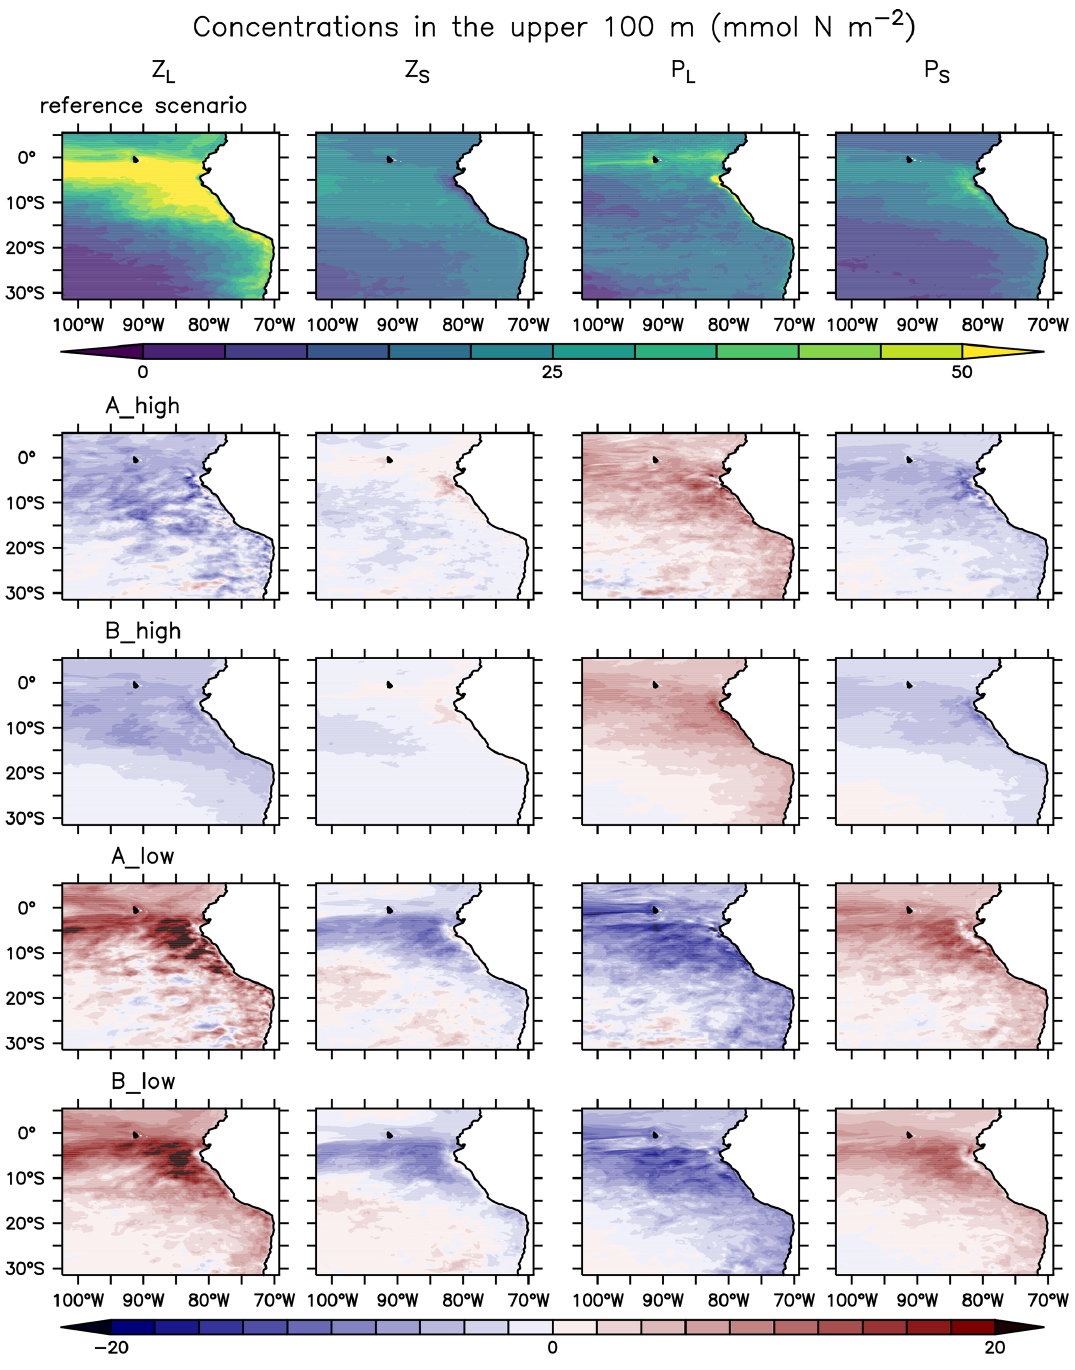
Figure D1. Large and small zooplankton ( Z S and Z L ) and large and small phytoplankton ( P L and P S ) integrated over the upper 100m of the water column (mmolNm − 2 ). Rows from top to bottom: reference scenario and difference between experiments A_high, B_high, A_low and B_low and the reference